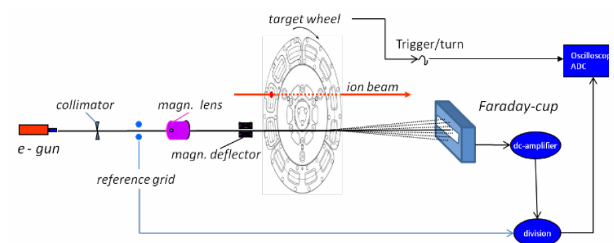
Fig.2. Scheme of the electron gun with associated electronics and target wheel